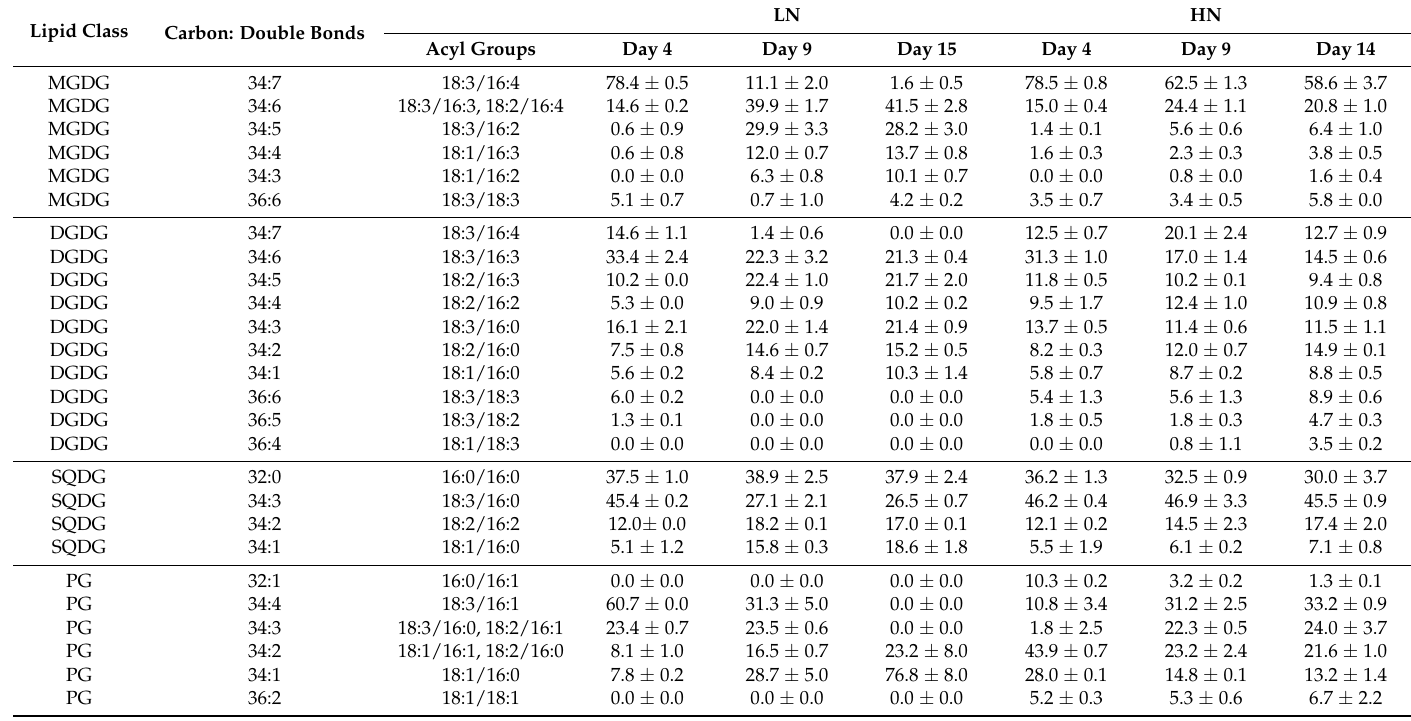
Table 1. Relative abundance (%) of polar lipid species (as a function of total species concentration within class) in Chlorella sp. grown in batch cultures containing either LN or HN media. Lipid classes were monogalactosyldiacylglycerol (MGDG); digalactosyldiacylglycerol (DGDG); sulfoquinovosyldiacylglycerol (SQDG); phosphatidylcholine (PC); phosphatidylglycerol (PG); phosphatidylethanolamine (PE), diacylglyceryl trimethyl homoserine (DGTS). The carbon:double bond column refers to the total number of carbon atoms and double bonds of acyl groups attached to the diglyceride moiety and the acyl groups column refers to the dominant fatty acid combinations as detected in MS/MS spectra (see Materials and